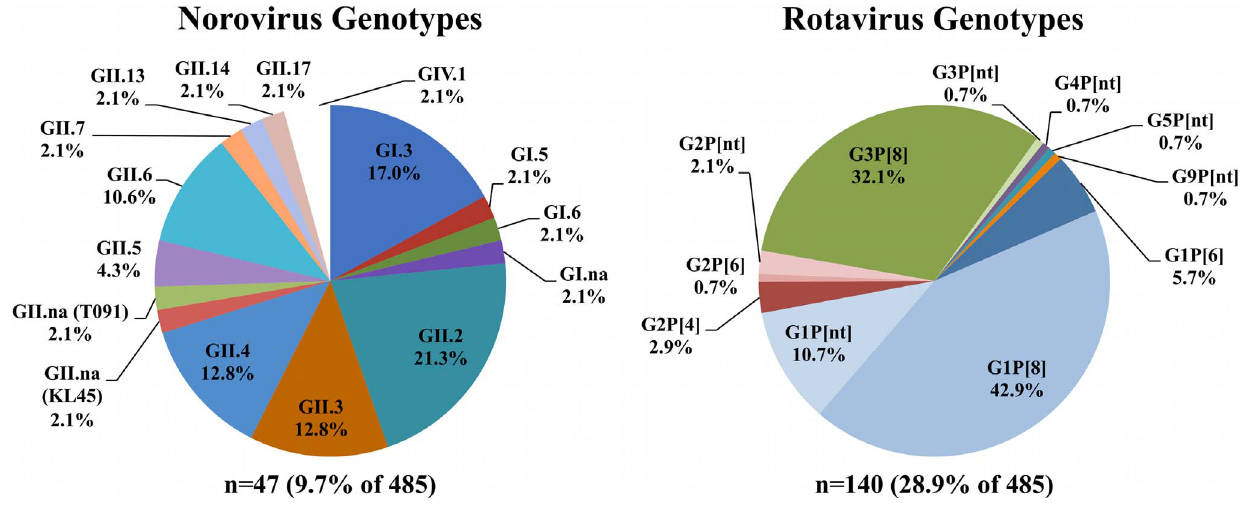
Figure 2. Overall distribution of rotavirus and norovirus genotypes detected in this study.